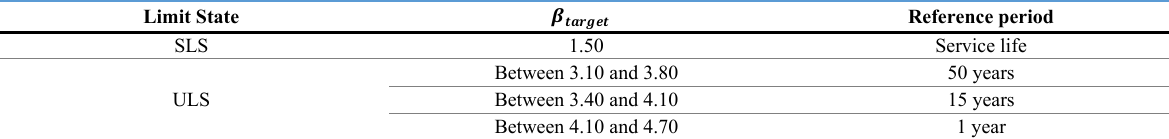
Table 1. Suggested target reliability indices for existing structures, Model Code 2010 [15].